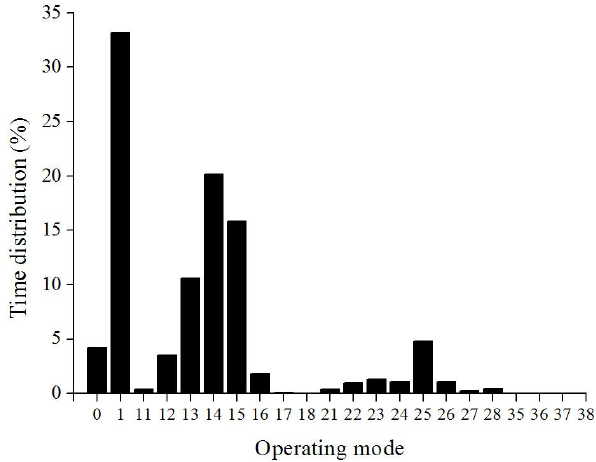
Fig. 2. Allocation of time of each operating mode bin to total time of the typical driving cycle for urban buses in Beijing, with an average speed of 18kmh − 1 .